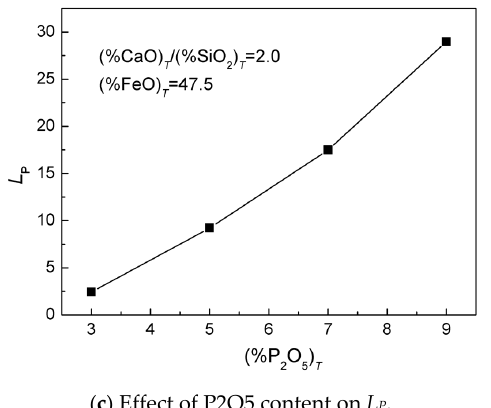
Figure 7. Effect of the components of the initial slag on L P . Note: The subscript t represents the experimental initial slag, which is the same below.